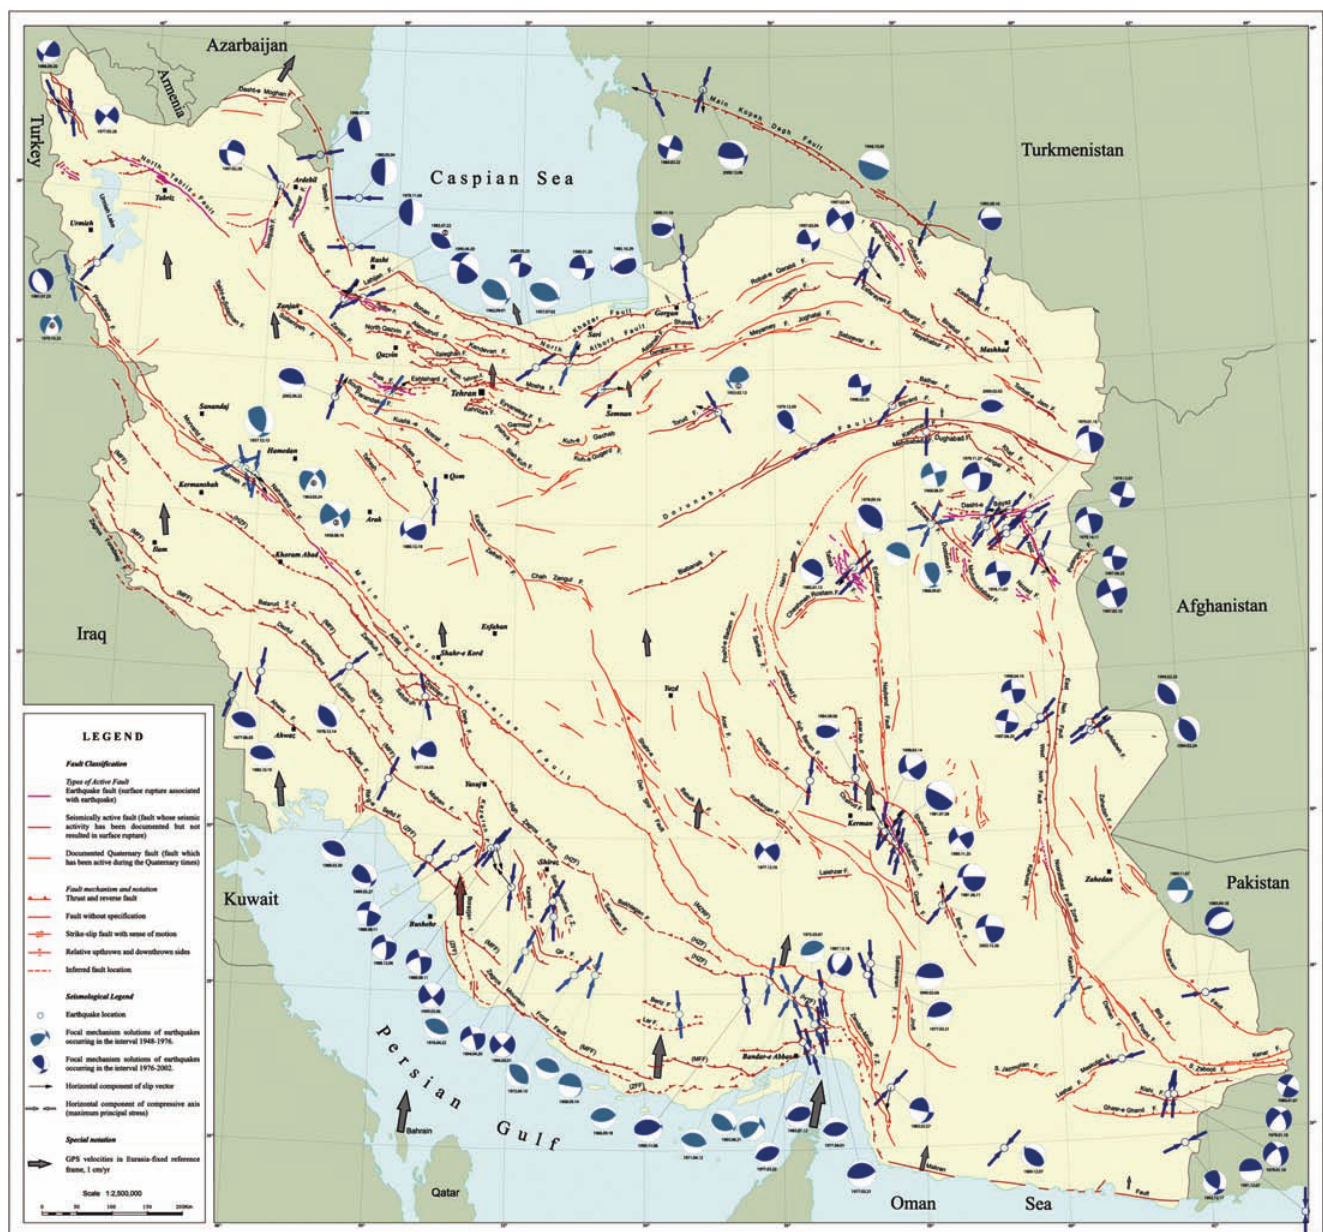
Figure 4. The fault lines in the Iran area [from the website of the International Institute of Earthquake Engineering and Seismology (Tehran, Iran),